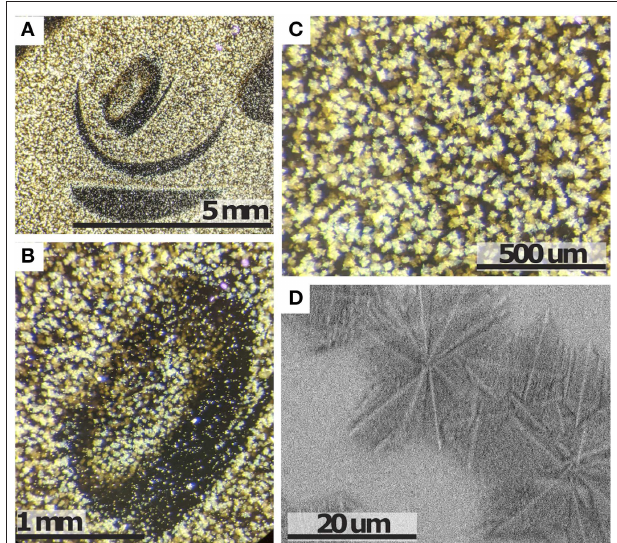
FIGURE 6 | Textural characteristics of the sample extracted from the furnace after rheological experimentation. (A–C) Reflected light photomicrographs at increasing magnification. The textures in (A,B) are a result of distortion of the melt upon extraction of the spindle from the sample. Crystal habits are acicular, dendritic to fibrous and the crystals form low aspect ratio, “snowflake” type, clusters. (D) Close up of a back-scattered electron (BSE) photomicrograph of the crystal